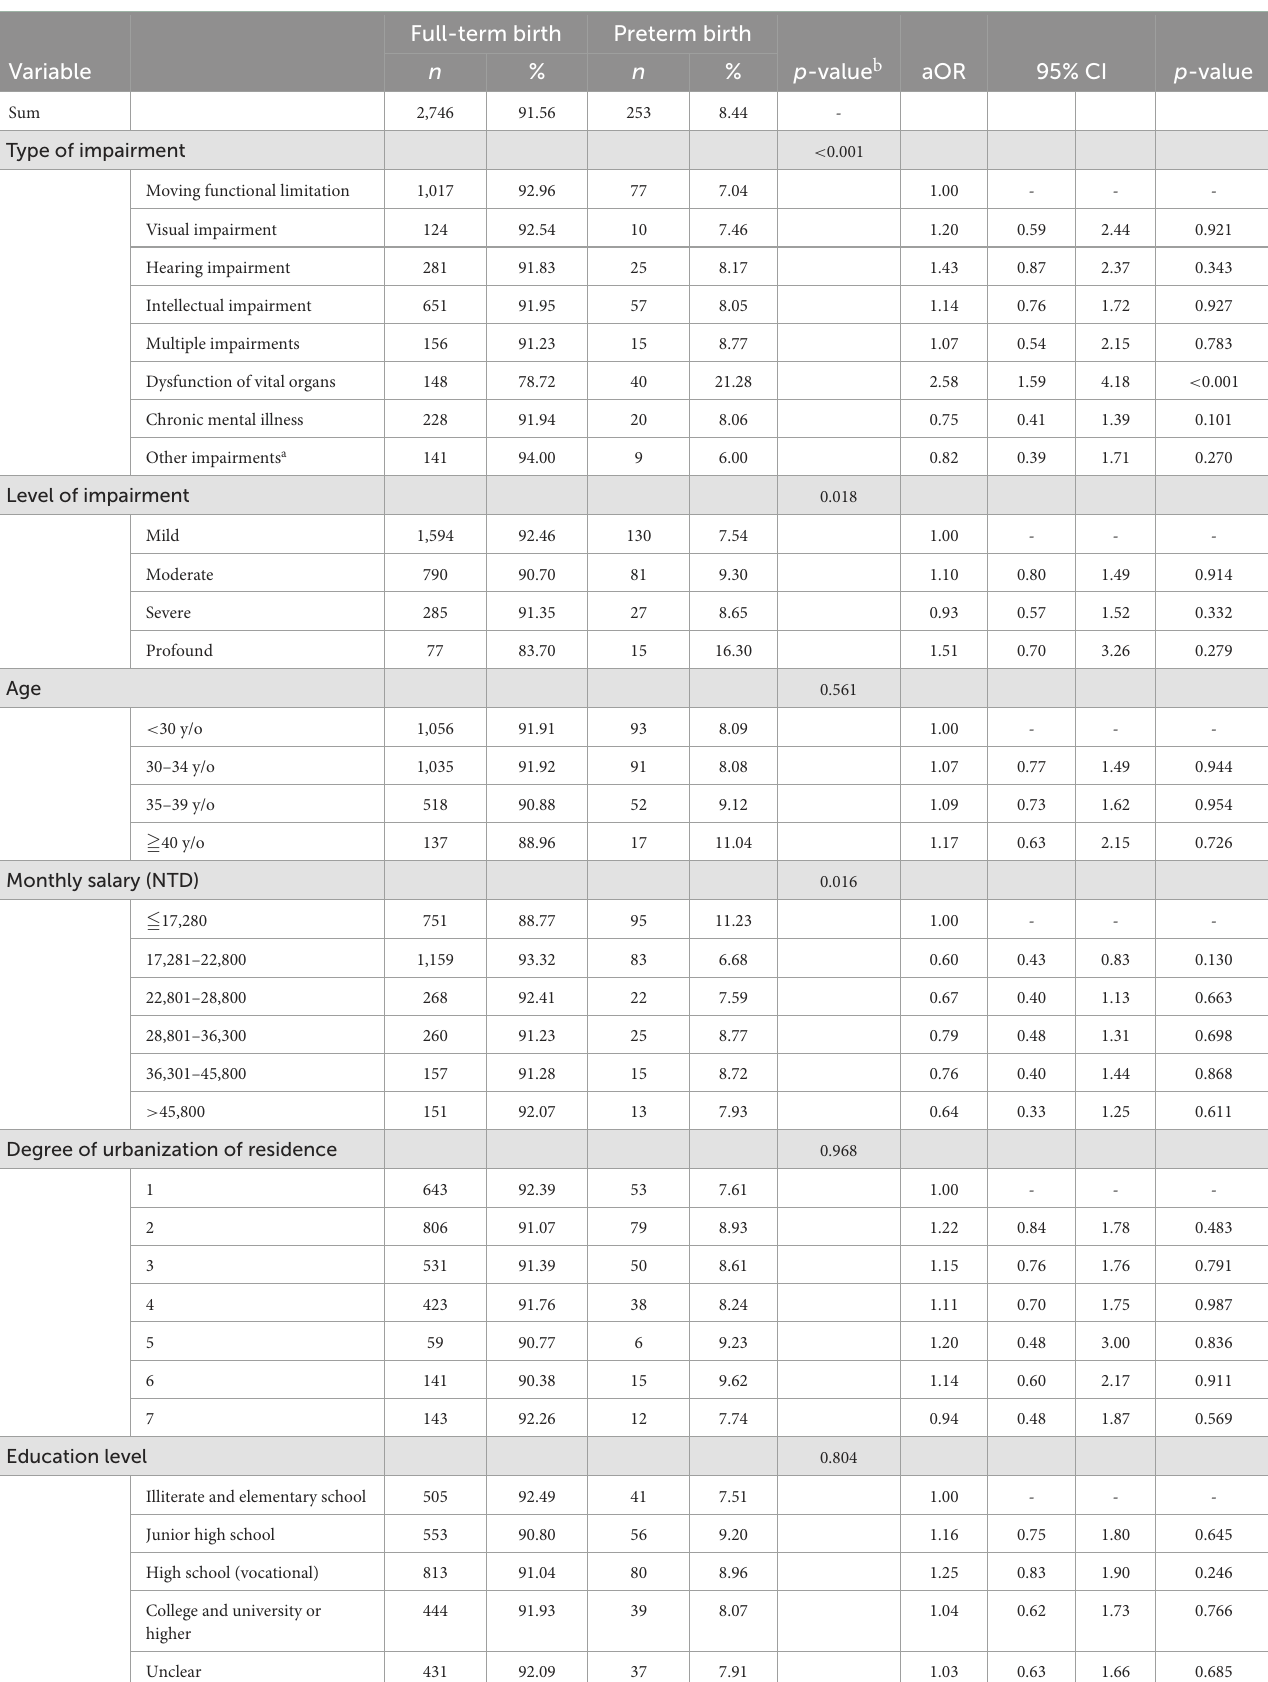
TABLE 5 The risk of preterm birth and related factors among pregnant women with disability.